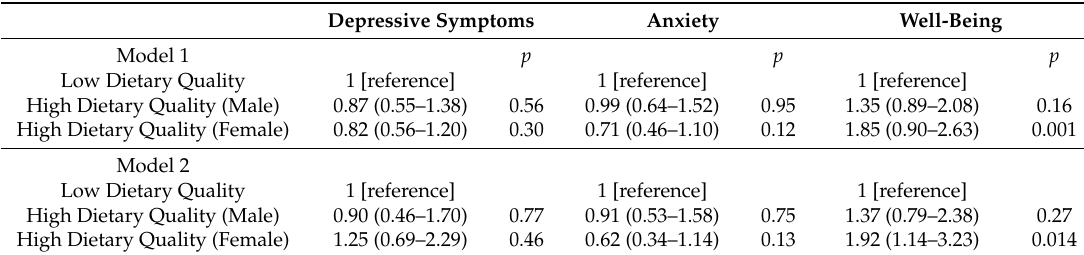
Table 3. Odds ratios (95% CI) for mental health outcomes according to dietary quality stratified by gender.